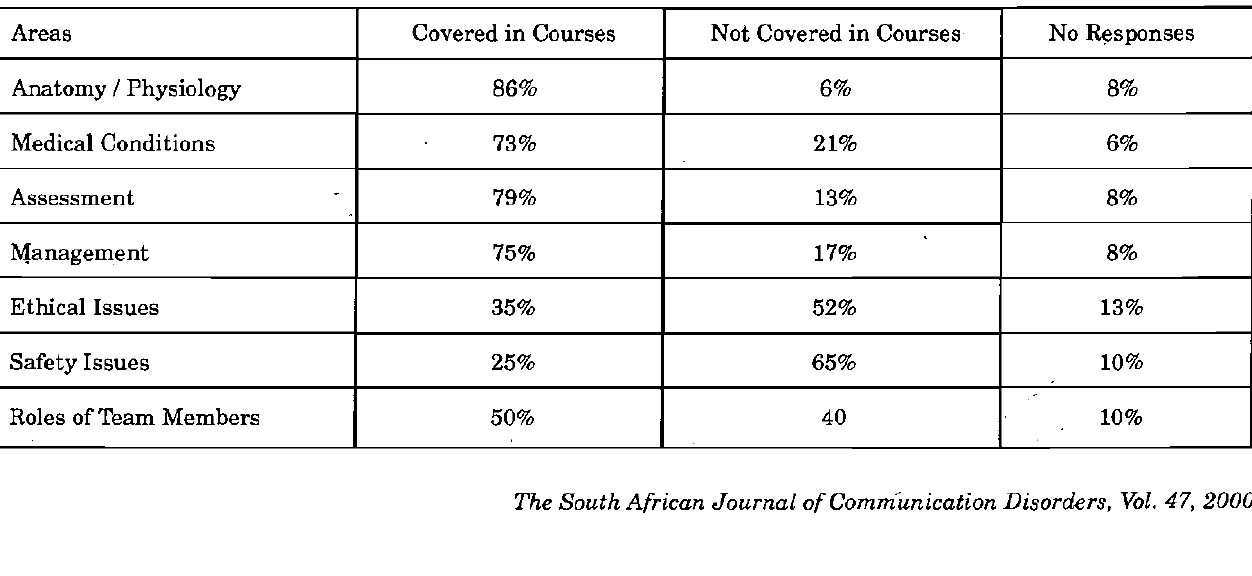
TABLE 3. Theoretical areas in dysphagia covered at an undergraduate level (N =